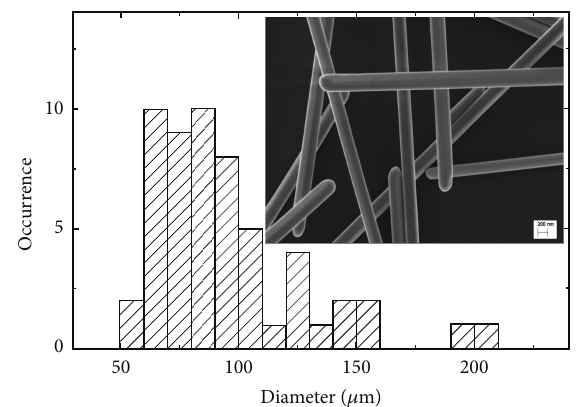
Figure 2: Histogram of the diameters of AgNWs determined from scanning electron microscopy images, example of which is displayed in the